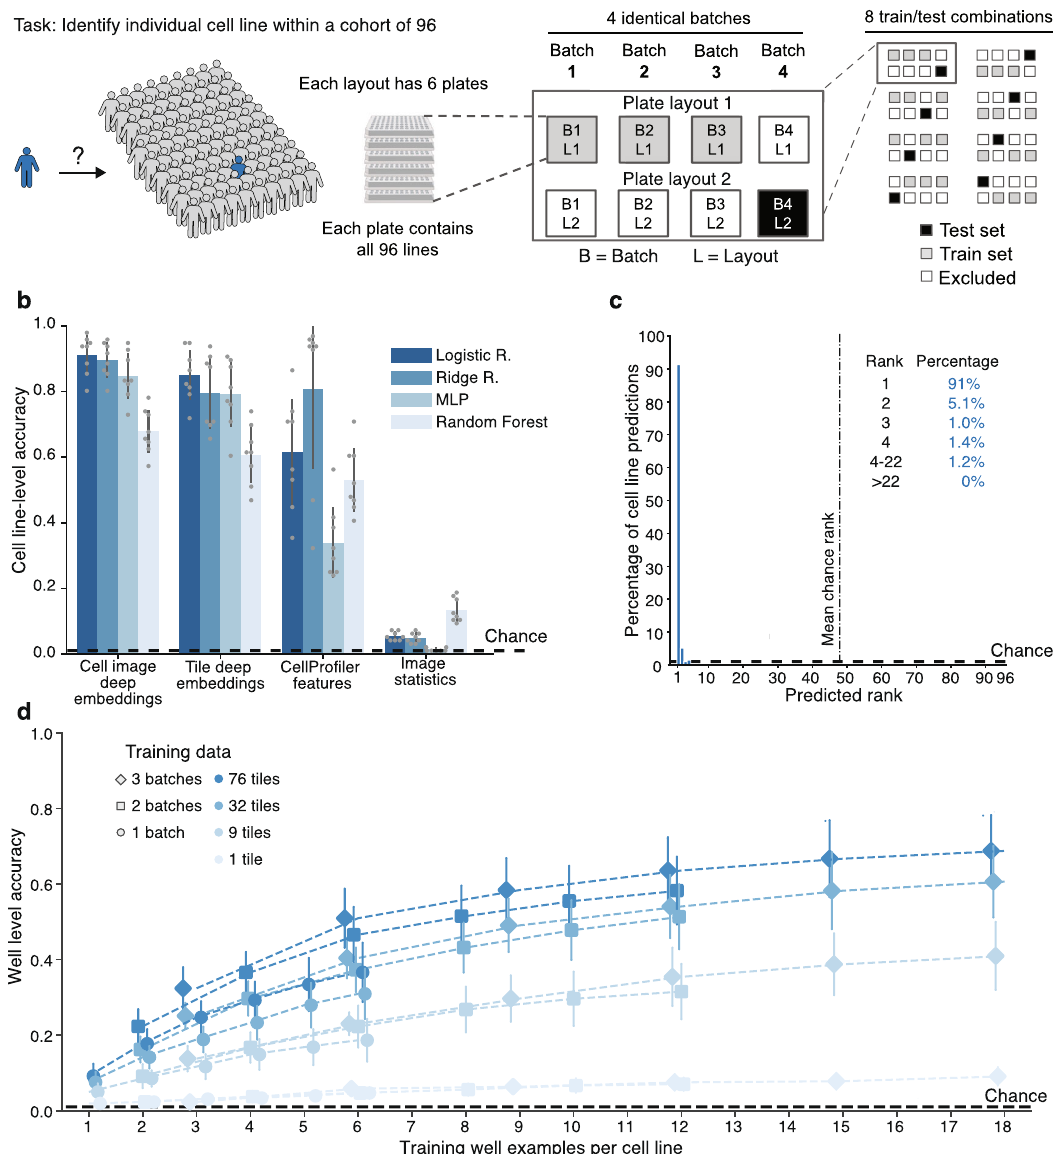
Fig. 3 Robust identi fi cation of individual cell lines across batches and plate layouts. a 96-way cell line classi fi cation task uses a cross-validation strategy with held-out batch and plate-layout. b Test set cell line – level classi fi cation accuracy is much higher than chance for both deep image embeddings and CellPro fi ler features using a variety of models (logistic regression, ridge regression, multilayer perceptron (MLP), and random forest). Error bars denote standard deviation across 8 batch/plate layouts. c Histogram of cell line – level predicted rank of true cell line for the logistic regression model trained on cell image deep embeddings from b shows that the correct cell line is ranked fi rst in 91% of cases. d A multilayer perceptron model trained on smaller cross sections of the entire dataset, down to a single well (average of cell image deep embeddings across 76 tiles) per cell line, can identify a cell line in a held- out batch and plate layout with higher than chance well-level accuracy; accuracy rises with increasing training data. Data are presented as mean values ± standard deviation. Dashed black lines denote chance